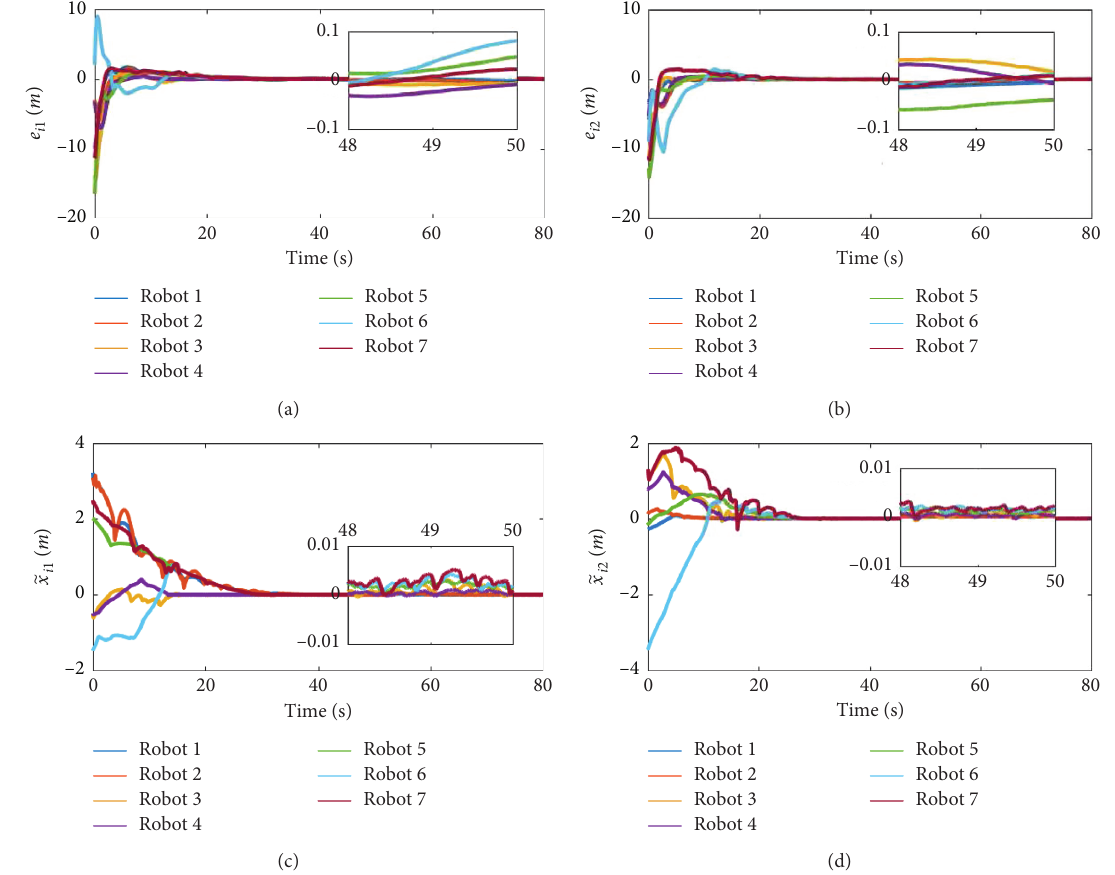
Figure 10: Evolution of e